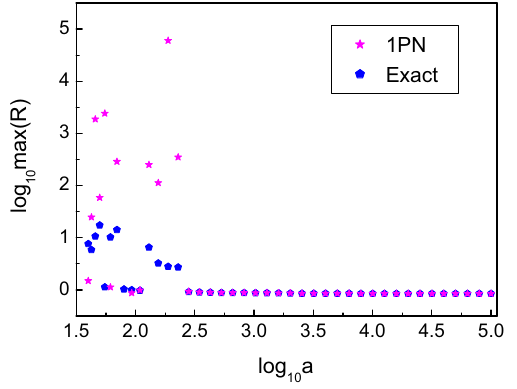
(cid:13) x 2 + y 2 on a